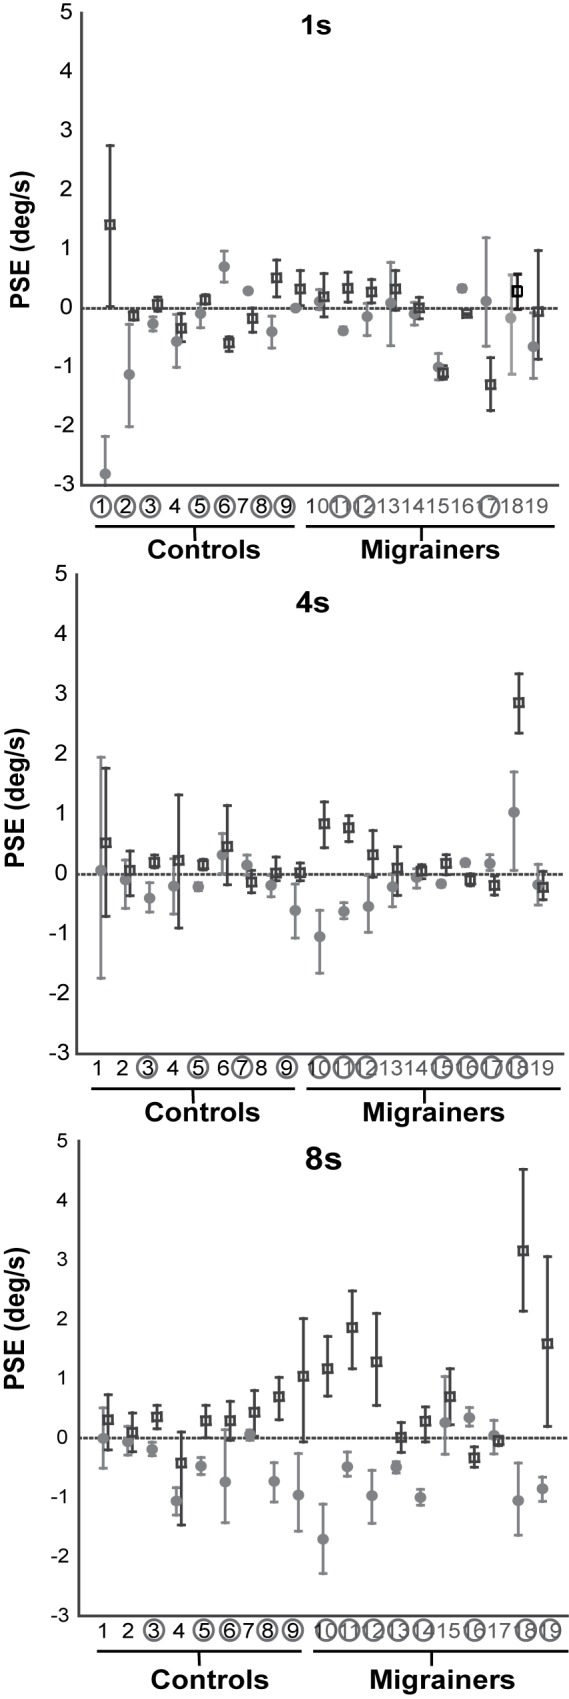
Individual subject data for 1s, 4s, and 8s PSE trials.Counterclockwise visual field motion (VFM) represented with filled circles, clockwise VFM with open squares. A positive PSE indicates that a neutral motion would be more likely to be perceived as clockwise self-motion, likewise a negative PSE indicates a neutral motion would be perceived as counterclockwise. Error bars represent 95% CI.